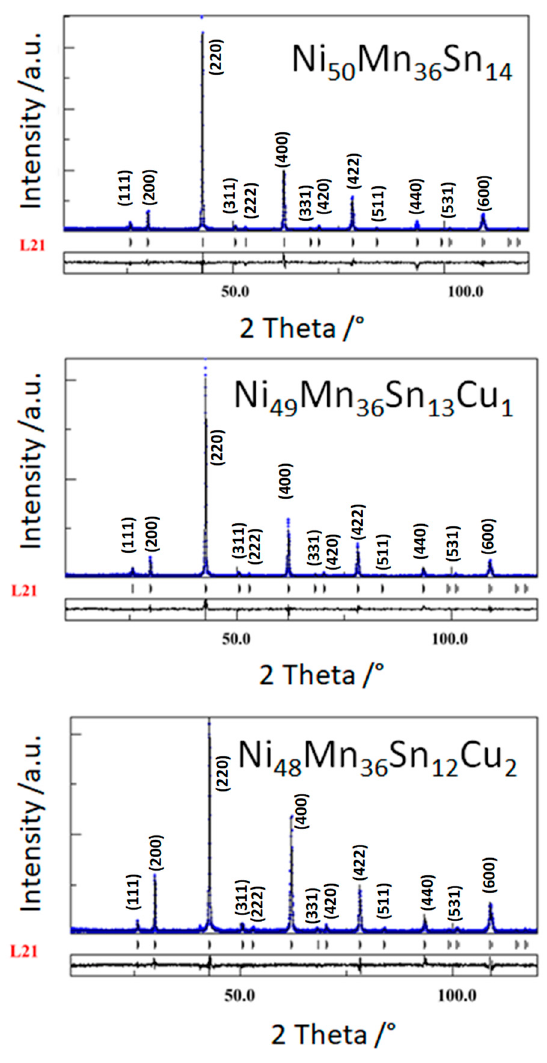
Figure 1. X-ray diffraction patterns of the Ni-Mn-Sn-(Cu) ribbons. Table 1. Crystallographic parameters obtained from XRD analysis of specimens before and after thermal cycling.